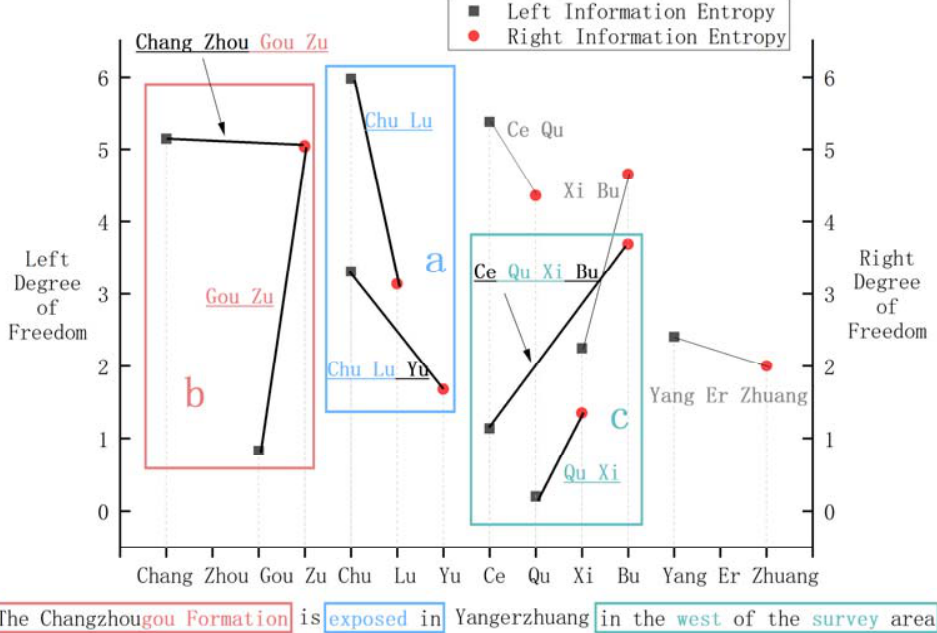
Figure 3. Logic visualization of inclusive conflict. ( a ) Same-starting-point inclusive conflict; ( b ) same-ending-point inclusive con fl ict; ( c ) inner inclusive con fl ict. Note: the color of the Chinese conflict is the same as in English.